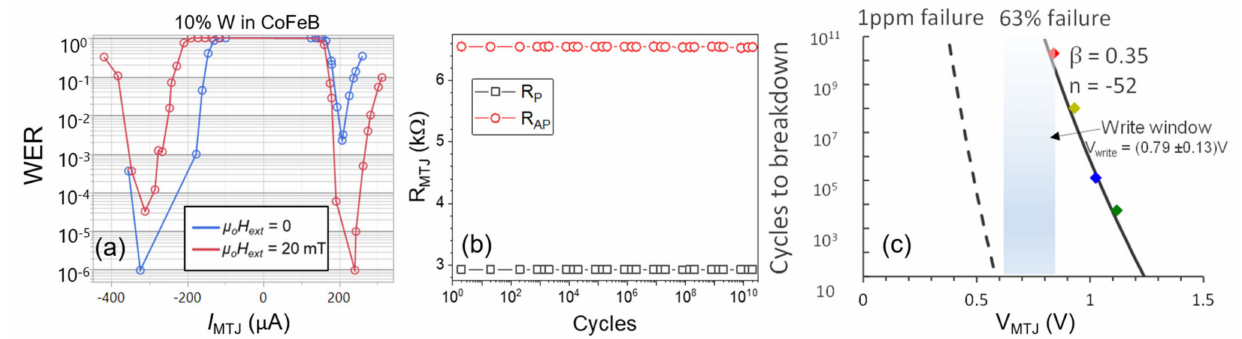
Figure 6. Reliability assessment of devices with W 0.1 CoFeB 0.9 FL at τ PW = 5 ns: ( a ) Experimentally measured write error rates as a function of external magnetic field ( µ o H ext ). 1 ppm (WER = 1 × 10 − 6 ) is demonstrated for both switch- ing directions through compensation of the stray field ( µ o H stray ); ( b ) evolution of device resistances (R P , R AP ) during 2 × 10 10 cycling events, no TMR degradation is observed; ( c ) lifetime extrapolations of the tested devices for 1 ppm failure based on four independent stress tests on fresh devices. Each colour indicates the biasing voltage at which 63% of the tested devices